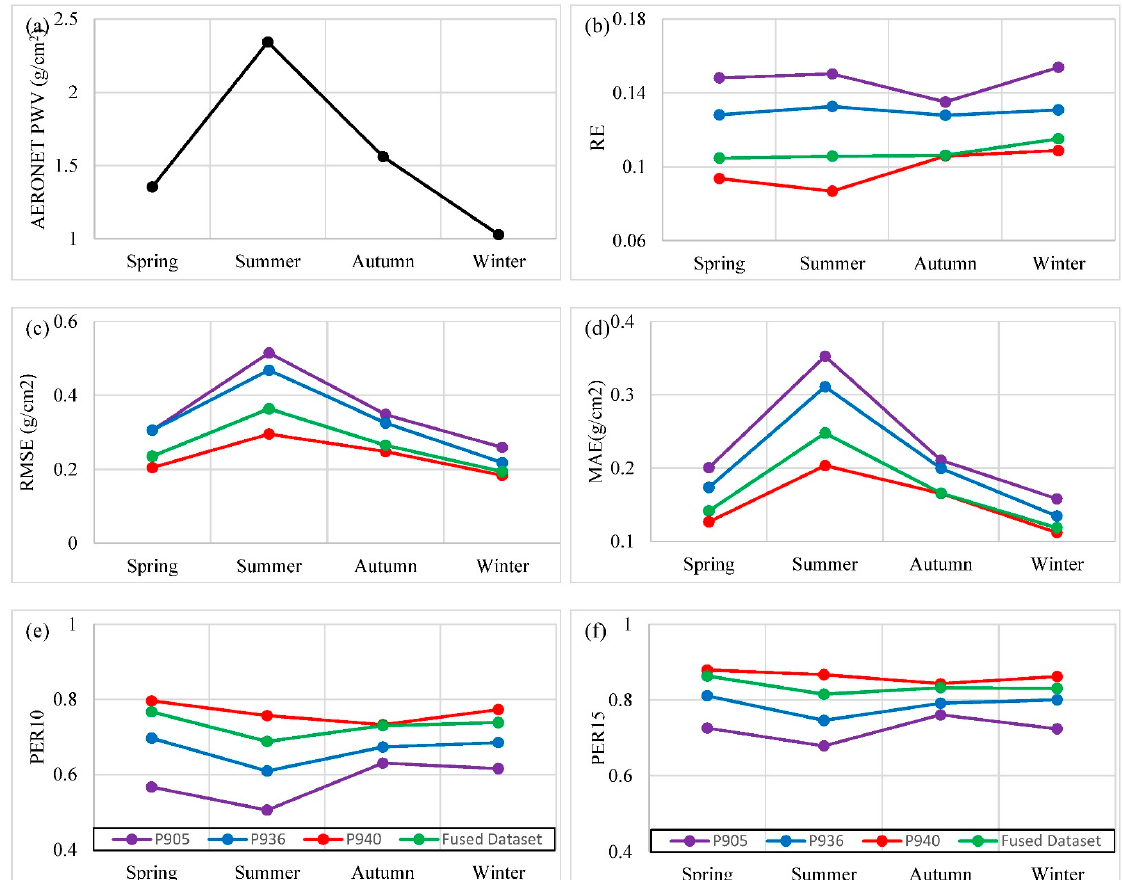
Figure 5. The mean values of AERONET PWV data and error of the four MERSI-2 PWV datasets in different seasons. ( a ) means values of AERONET PWV data; ( b ) REs of the four MERSI-2 PWV datasets; ( c ) RMSEs of the four MERSI-2 PWV datasets; ( d ) MAEs of the four MERSI-2 PWV datasets; ( e ) PER10s of the four MERSI-2 PWV datasets; ( f ) PER15s of the four MERSI-2 PWV datasets.